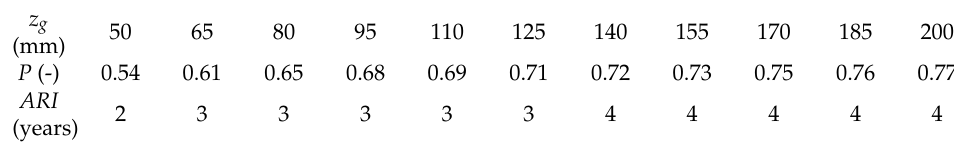
Table 9. Analysis results in summer, GREEN ROOF 1.